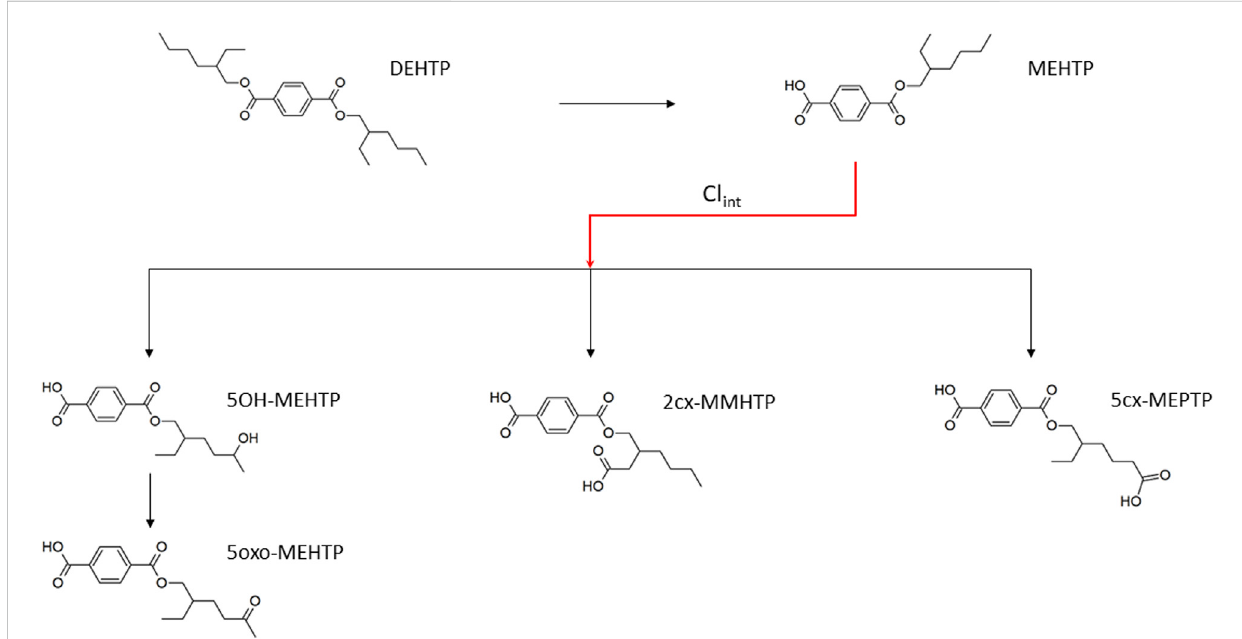
FIGURE 1 MetabolicpathwayofDEHTPto thespeci fi c,side-chain-oxidized monoesters measuredinthecontrolledhumanexposure studyofLessmannetal. (2016)andsimulatedusingthePBPKmodel.Theintrinsicclearance,Cl int forthebiotransformationofMEHTPtothethreeurinarymetabolitesisshownby thered arrow. Cleavageto the unspeci fi cmetaboliteterephthalic acid (TPA), and phaseII metabolism (conjugation with, e.g., glucuronicacid) not shown for simpli fi